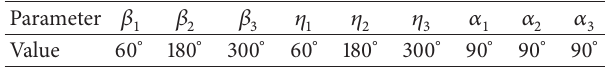
Table 1: A table with notes.